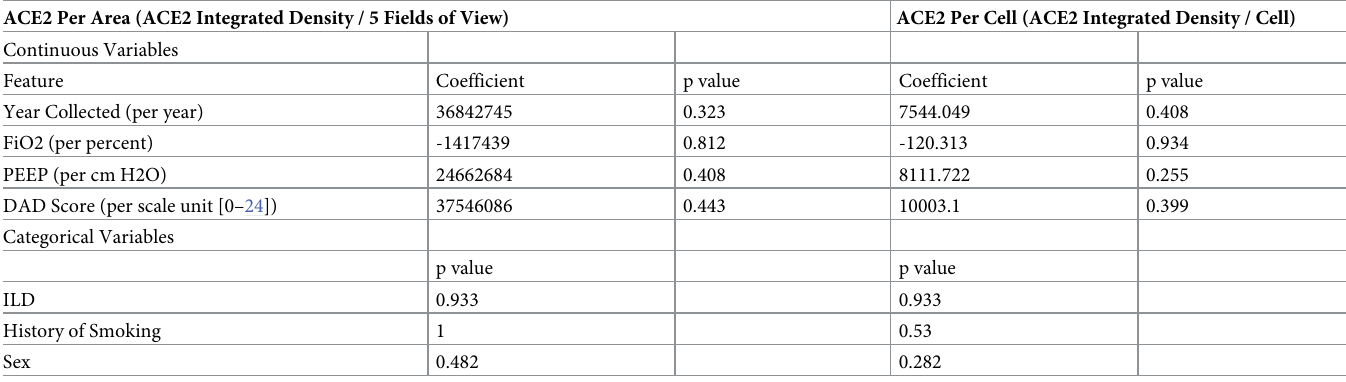
Table 1. Comparison of lung ACE2 expression with control